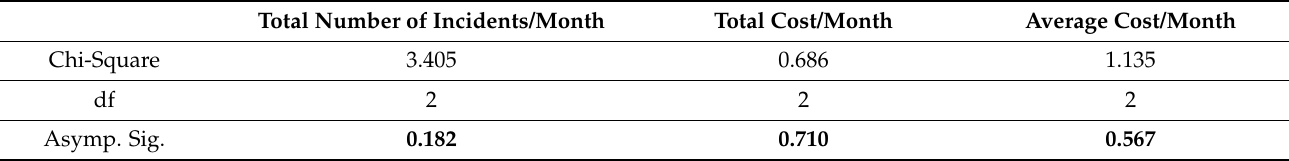
Table 3. Results for Kruskal–Wallis Test a,b .